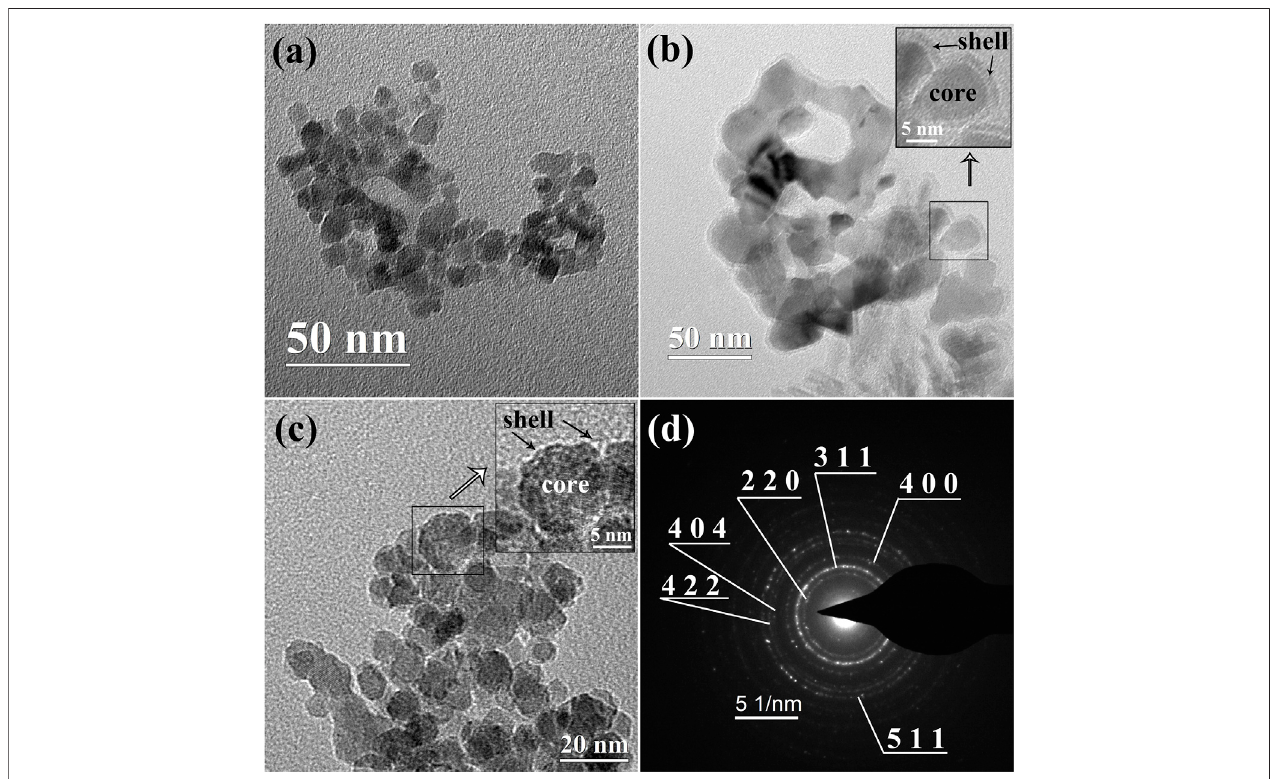
FIGURE3| TEMimagesof (A) BMmagneticnanoparticles, (B) P1magneticnanoparticles,and (C) magneticnanoparticlesP2.Theinsertsin (B,C) arethecoating details in the selected area. (D) : selected area electron diffraction (SAED) of BM.